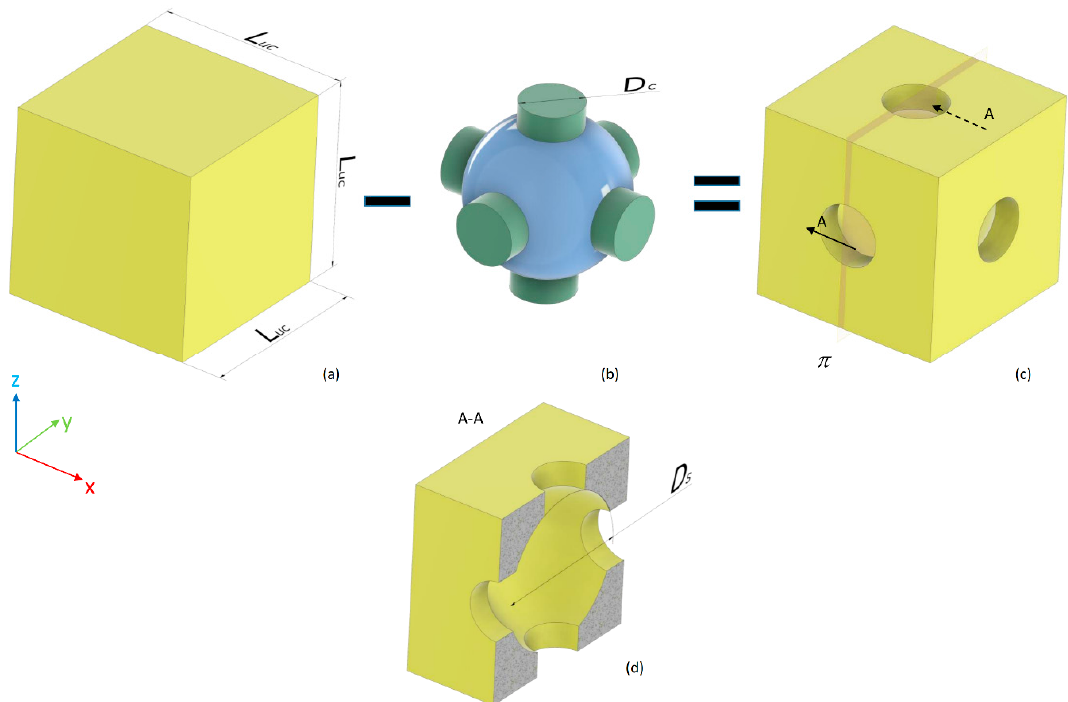
Figure 1. To build the scaffold unit cell ( c ), a boolean subtraction was carried out between a cubic volume (side L uc = L / 4) ( a ) and the volume of a sphere (highlighted in blue) with cylinders (highlighted in green) oriented orthogonally according to the coordinate axes ( b ). The section A-A view ( d ) with the plane π ( c ), shows how the unit cell is interiorly made.